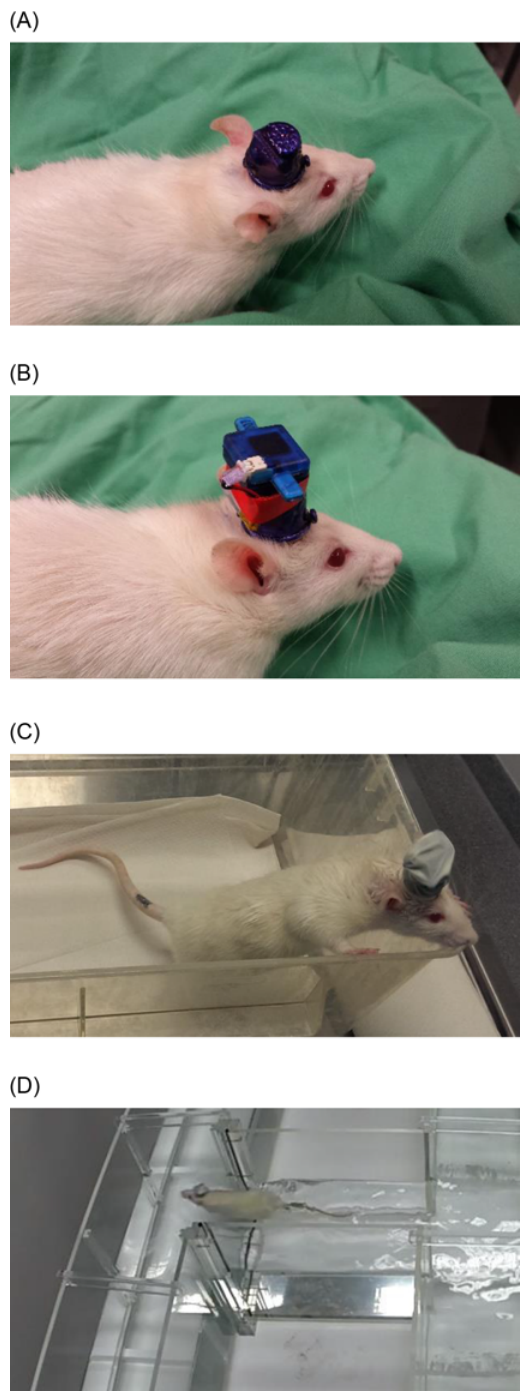
Fig 3. Photographs of Waterproof Connector. The wireless system connector provides stability for the wireless system, and is shown both without (A) and with (B) the W32 wireless system (Multichannel Systems Gmbh; Germany). With the waterproofing latex finger-cot (C), the rat is able to swim freely about the water maze (D) whilst LFP is transmitted wirelessly.